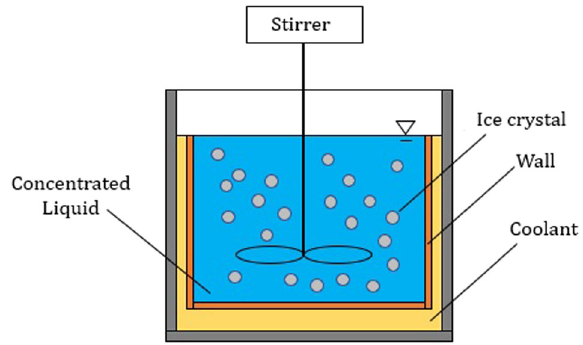
Fig. 3 Schematic of the suspension freeze-concentration process. The method produces many small ice crystals suspended in a concentrated